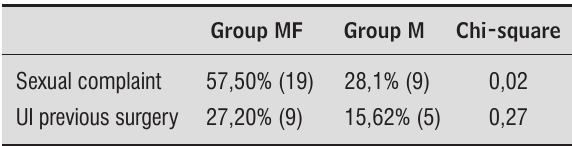
Table 3 - Characterization regarding sexual complaint and previous